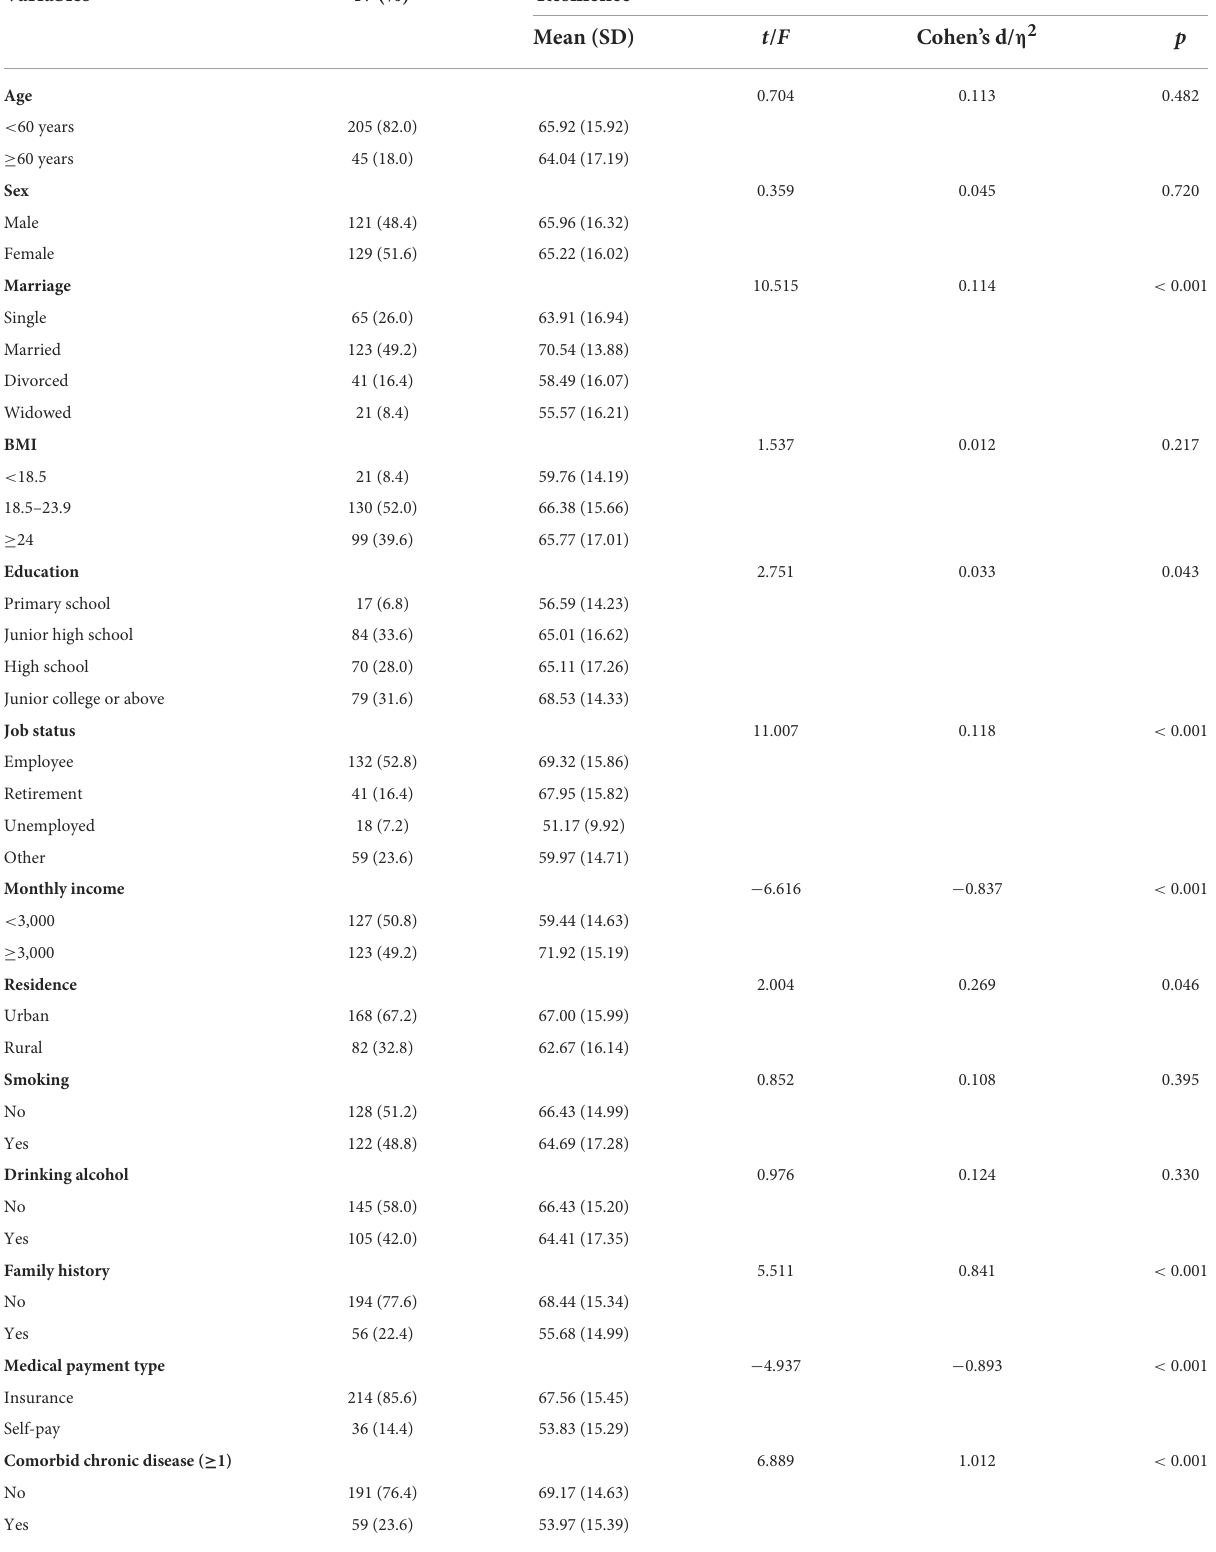
TABLE 1 Demographic characteristics and the level of resilience among patients with cervical spondylosis ( n = 250).